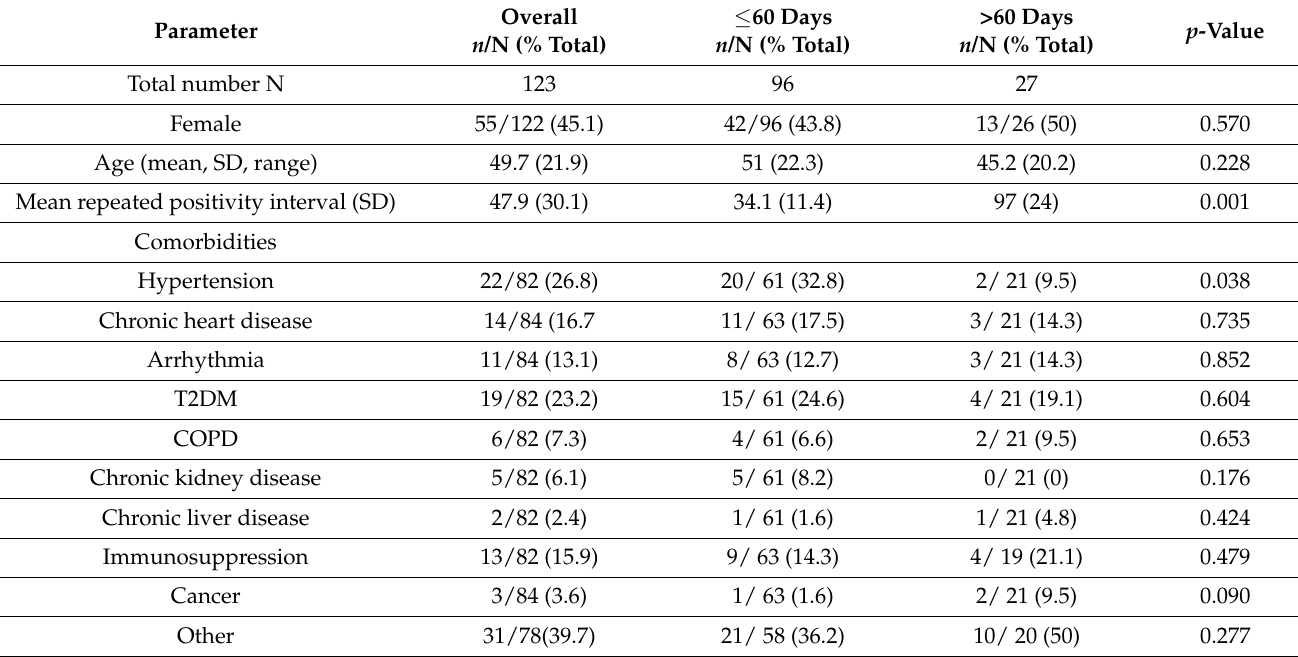
Table 1. Baseline characteristics of the overall analyzed population and comparison of patients with repeated positivity length under 60 with patients above 60